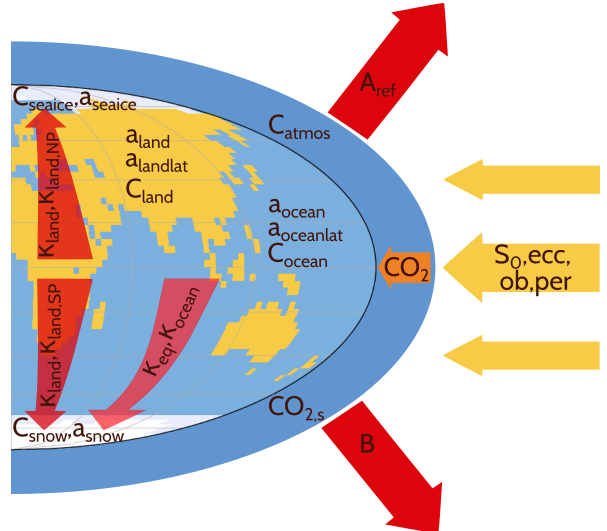
Figure 2. Conceptual view of the forcings, energy transport, and parameterizations in TransEBM. Solar insolation S 0 , the orbital pa- rameters, – eccentricity, obliquity, precession of the perihelion – CO 2 , land, sea, and ice distribution serve as forcings. The surface types differ by albedo a , which affects the insolation field, and heat capacity C . The energy from incoming solar radiation is transported poleward according to the thermal conductivities κ . The outgoing radiation is calculated based on the parameters A , B , and the re- sponse to CO 2 scaled by CO 2 , s .